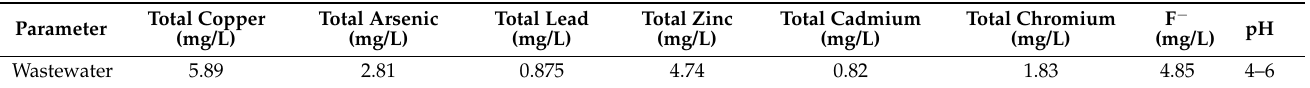
Table 1. Wastewater